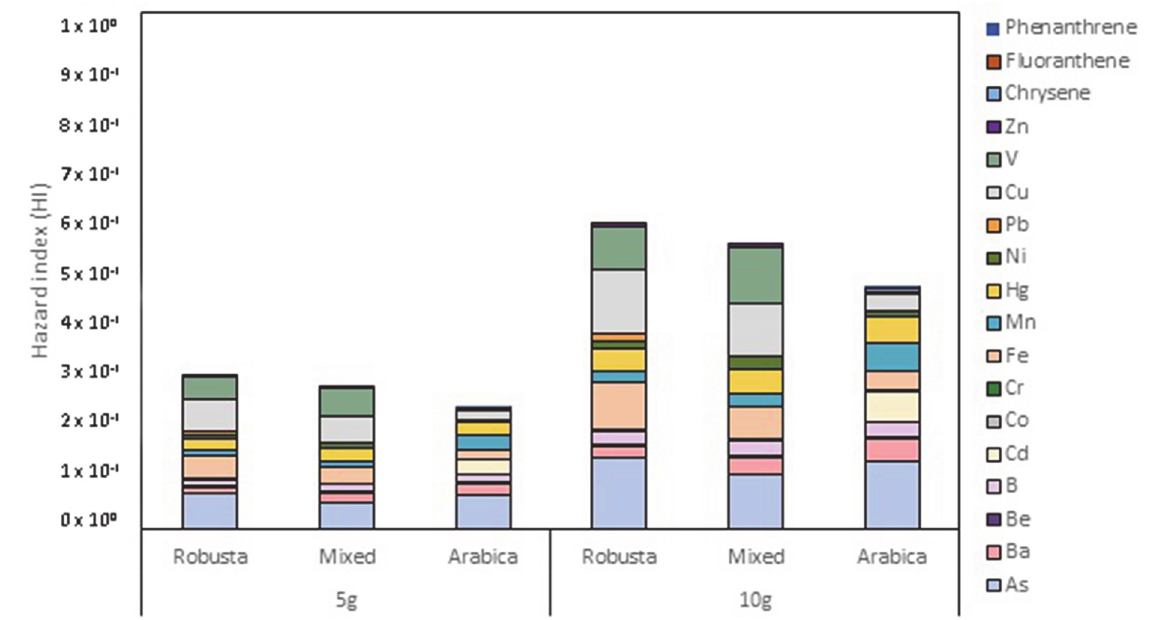
Figure 1. Hazard index (HI) evaluation based on the consumption of 5 g and 10 g of robusta , mixed and arabica silverskin.